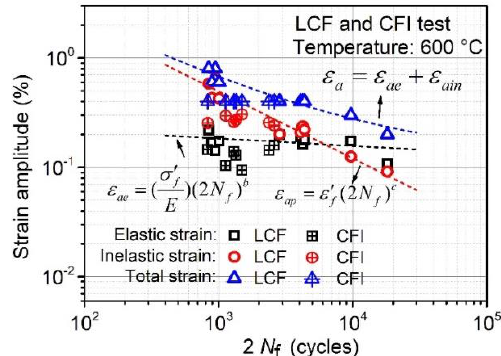
Figure 5. Relationship between strain amplitude and cycle number of fatigue life at LCF and CFI loadings.